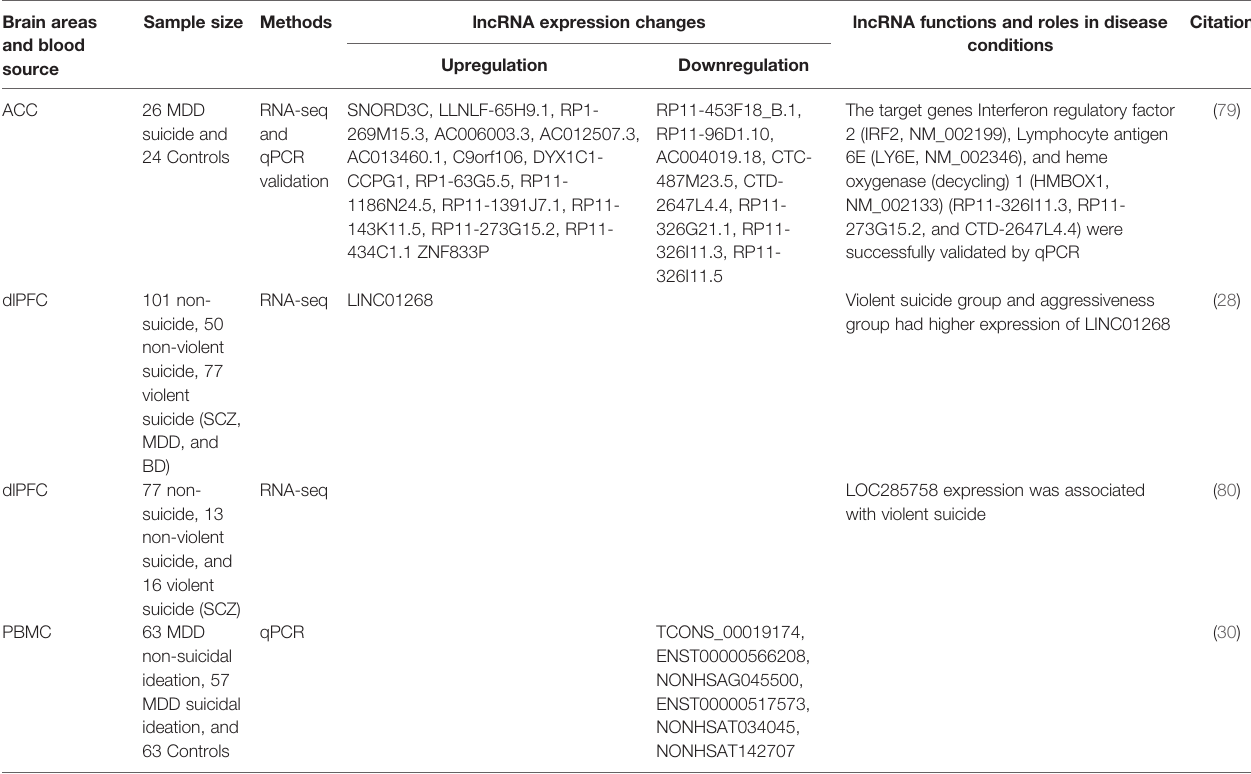
TABLE 2 | LncRNA expression changes in postmortem brain of suicide